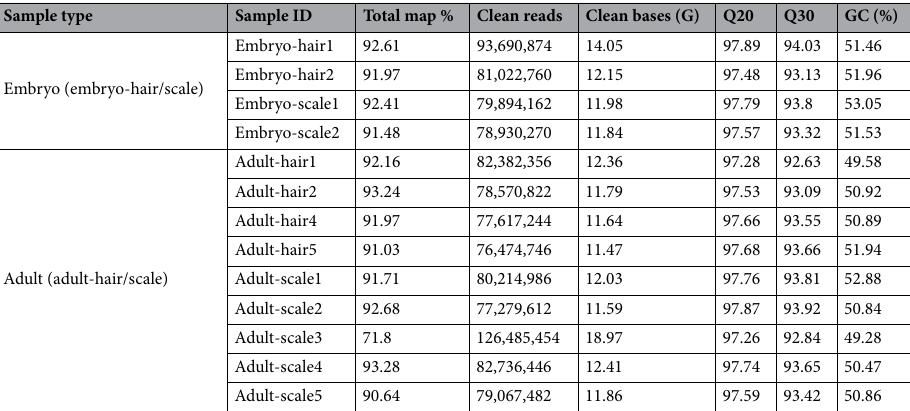
Table 1. Statistics of sequencing data quality and reference genome